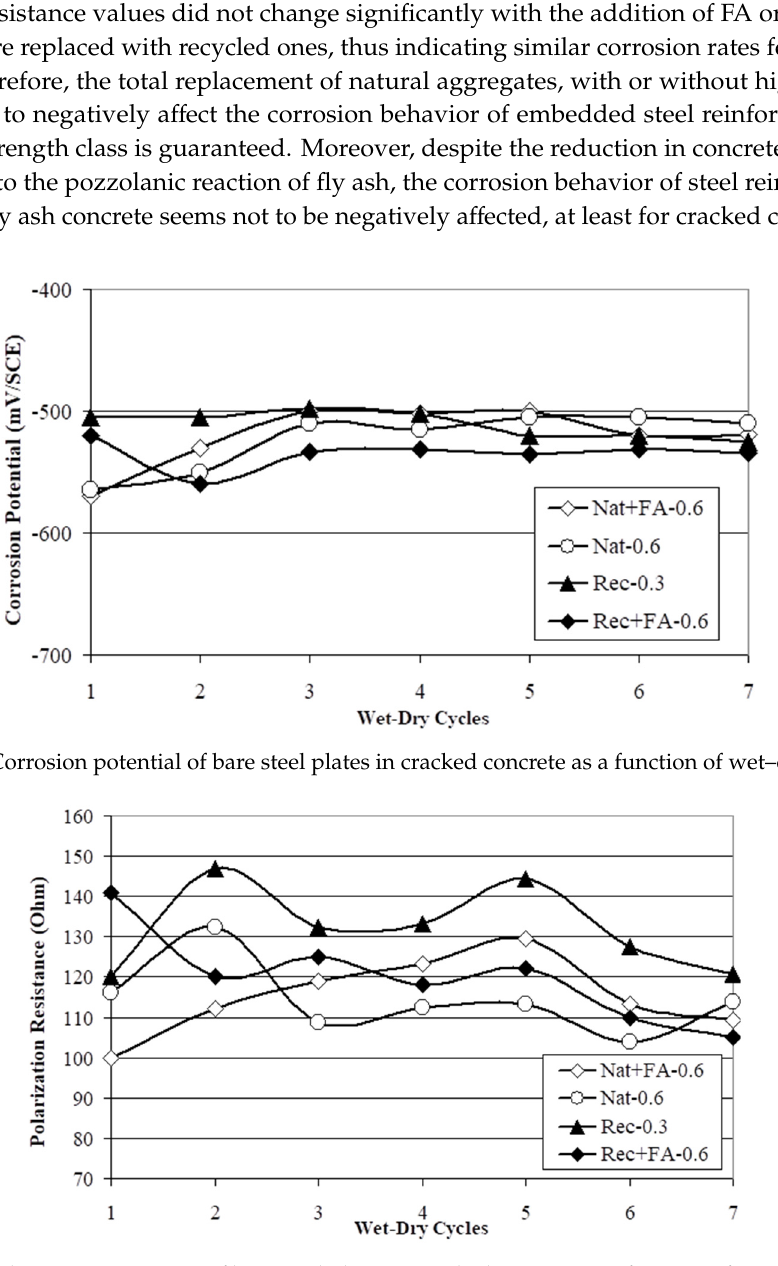
Figure 6. Polarization resistance of bare steel plates in cracked concrete as a function of wet–dry cycles.